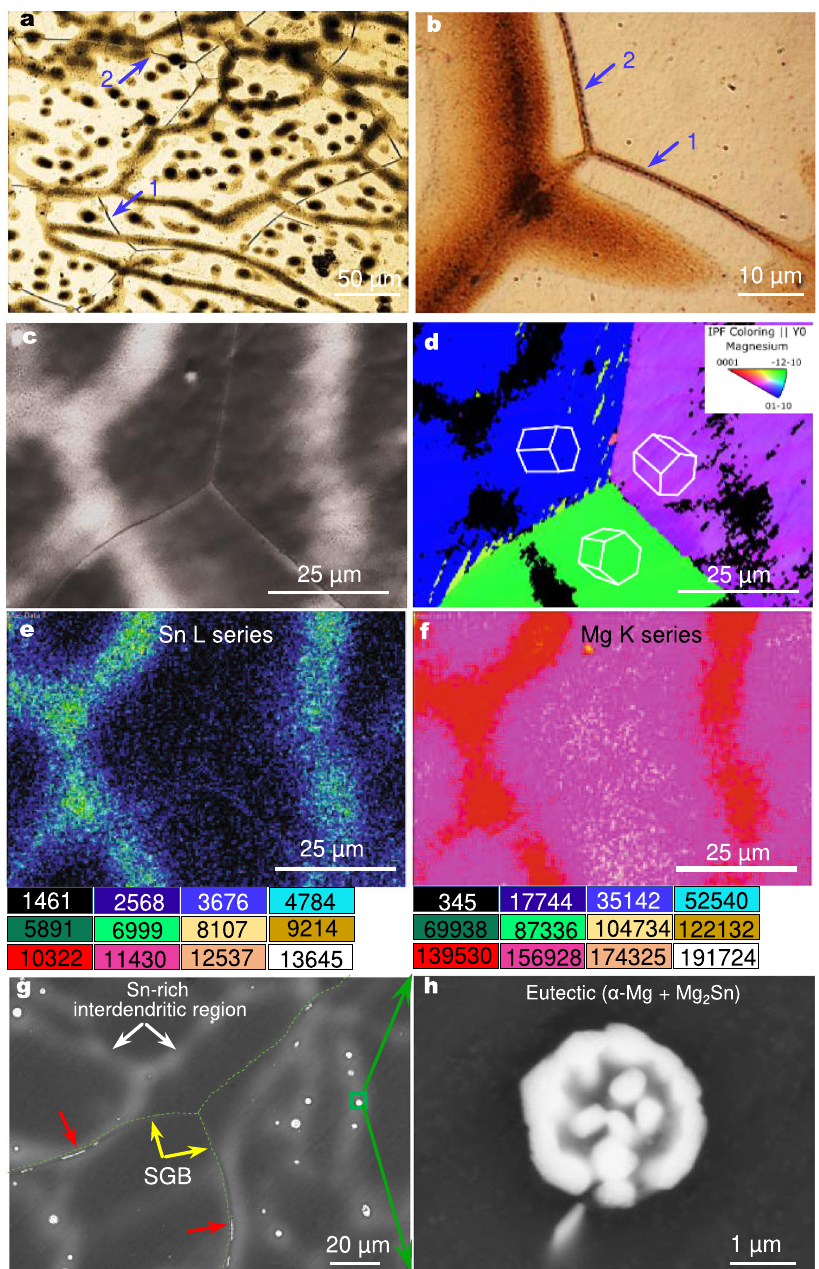
Fig. 2 | SGBM in as-cast Mg-0.63at.%Sn (3 wt.%) alloy. a , b Optical micrographs showinglargeSGBM(arrows1and2in a )and localisedsmallSGBM(arrows1and2 in b ). c Aforescatterdetector(FSD)imageshowingmigratedSGBsandSn-enriched interdendritic regions (bright). d EBSD inverse pole fi gure (IPF) map of c , showing different orientations of each grain at the triple junction in c , con fi rming the observed GB triple junction, where the dark regions are zero-solution regions, which cannot be indexed as Mg by the AZtec software due to Sn enrichment.